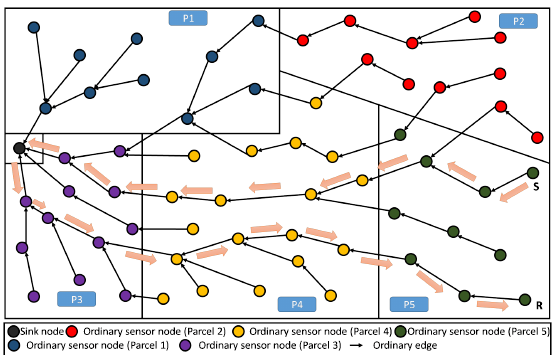
Figure 17. Spatial queries dissemination with PA-RPL.